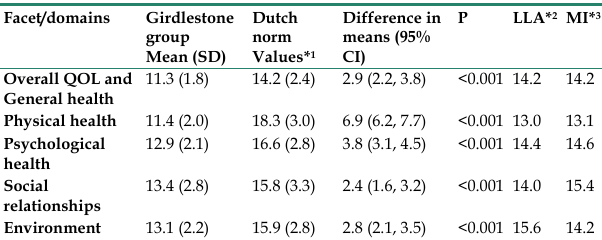
2. World Health Organization Quality of life (WHOQOL-BREF) facet and domain scores (range 4-20) compared with normative data and disease specific entities